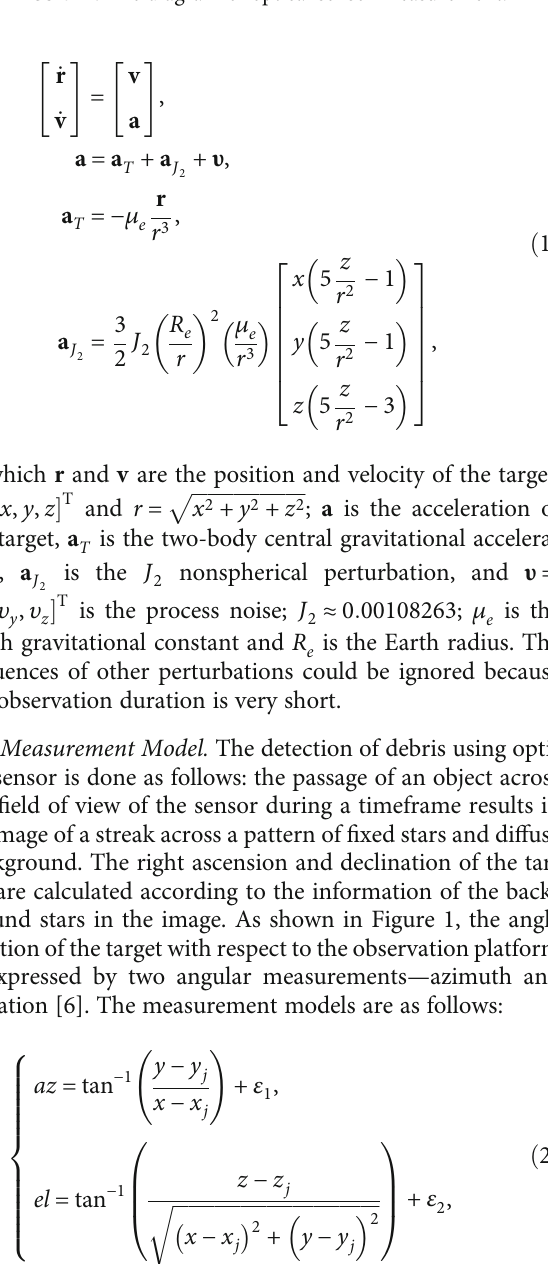
Figure 1: The diagram of optical sensor